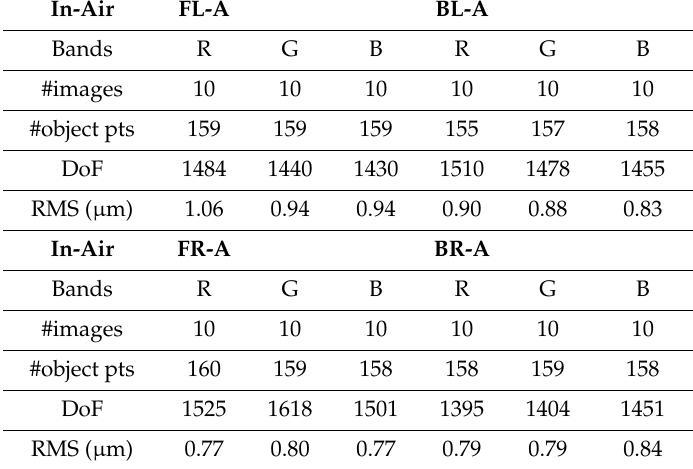
Table 2. Least square adjustment results of the independent (IDP) adjustment for all in-air datasets showing for each dataset the #images, #object points observed, the degree of freedoms (DoF) and the Root Mean Square (RMS) values. Only one repeat of BL-A is shown. All other BL-A repeats achieved similar results.